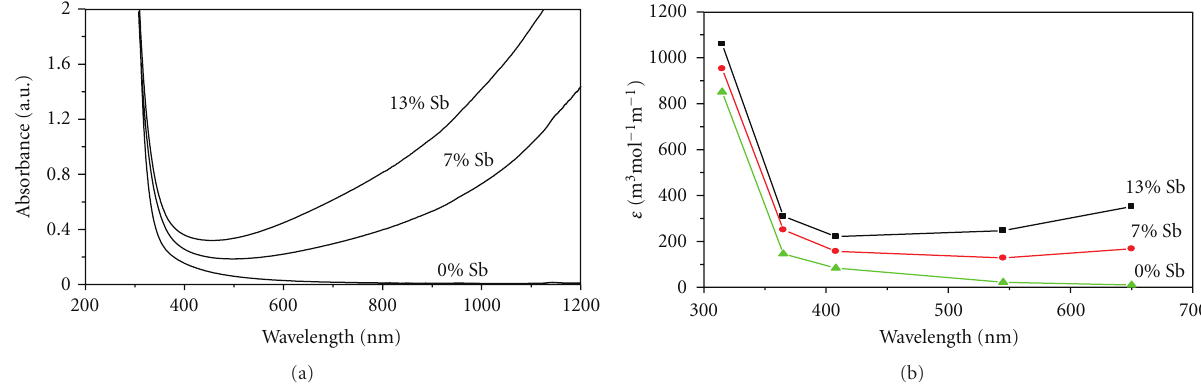
Figure 2: (a) UV/Vis absorbance spectra of Sb: SnO 2 nanoparticles in aqueous dispersion. The Sb :SnO 2 particle concentration is 0.23 wt%. (b) Molar extinction coe ffi cients, ε , of Sb :SnO 2 nanoparticles as a function of wavelength for di ff erent Sb-doping levels, determined from (a).